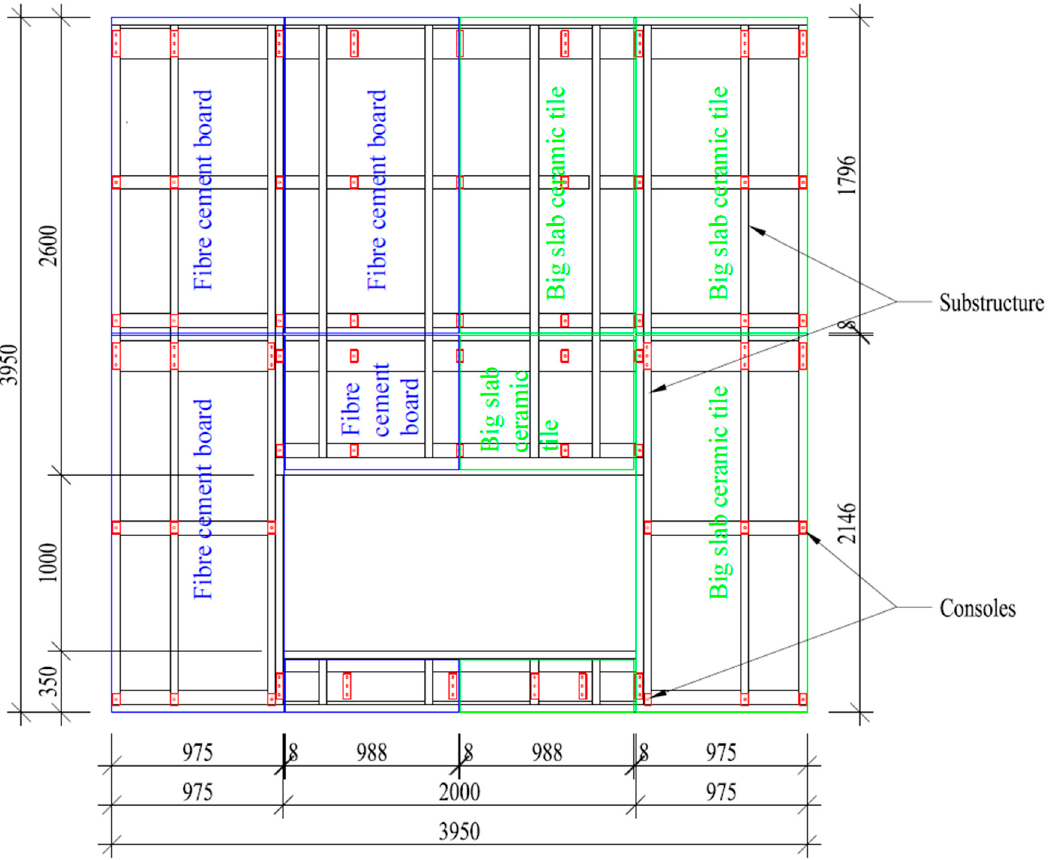
Figure 1. Scheme of the aluminum substructure, console arrangement, external cladding panels arrangement and material indication.